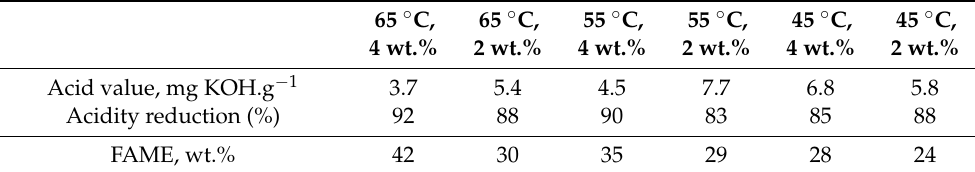
Table 3. Characteristics of the homogenous acid esterification final product. Acid value, mg KOH.g − 1 3.7